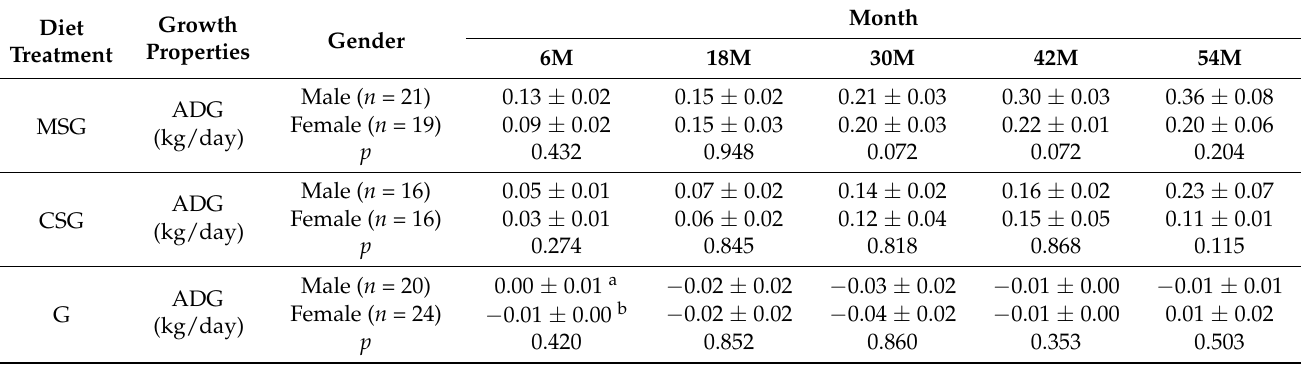
Table 4. The average daily gain of Tianzhu white yaks various with gender.